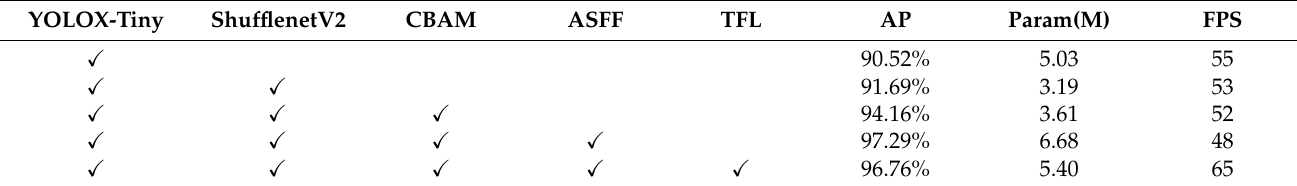
Table 2. Ablation